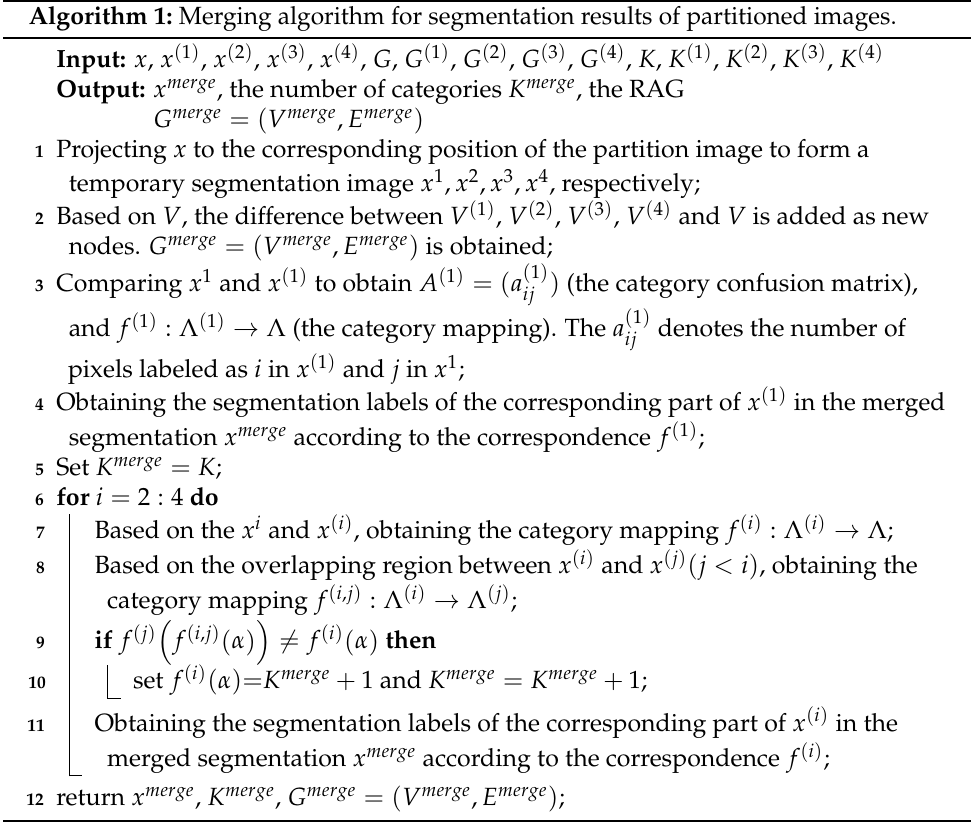
Algorithm 1: Merging algorithm for segmentation results of partitioned